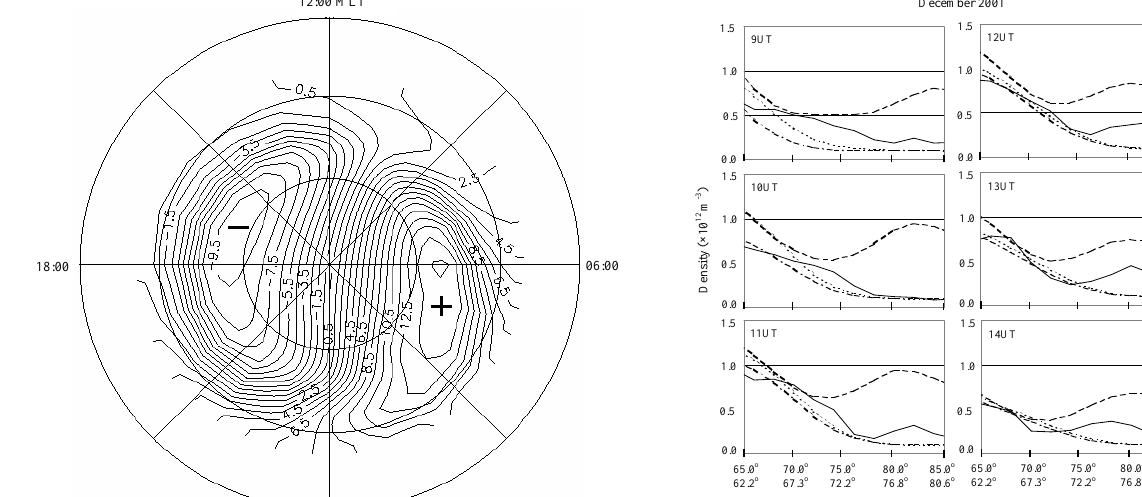
Fig. 6. Ionisation densities from the CTIP model at 18 ◦ E and al- titude of 260km at hourly intervals from 09:00 UT to 14:00 UT with precipitation and convection inputs, M pc, (long dashed curve), convection input and precipitation switched off, M c , (long-short dashed curve) and no precipitation and no convection input, M, (short dashed curve). Also shown are the corresponding median electron densities from the tomography observations (solid curve) averaged over 2 ◦ latitude for comparison with the model